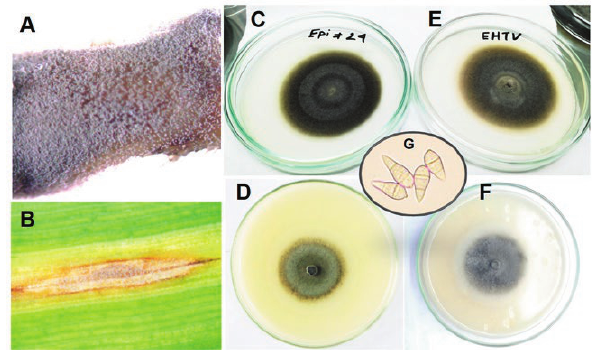
Figure 2. Growth of durum blast pathogen isolates on infected rachis and leaf tissues, and in PDA and OMA cultures after incu- bation under laboratory conditions. (A) gray to dark gray conidia of the fungus on an incubated rachis; (B) grayish conidia spores on an incubated leaf lesion; mono-conidium colonies of iso- late DuBWMRI1901.2A on PDA (C), and OMA (D), and of DuBWMRI1902.76C PDA (E) and OMA (F); and (G) compound light microscope image of two-septate pyriform conidia.